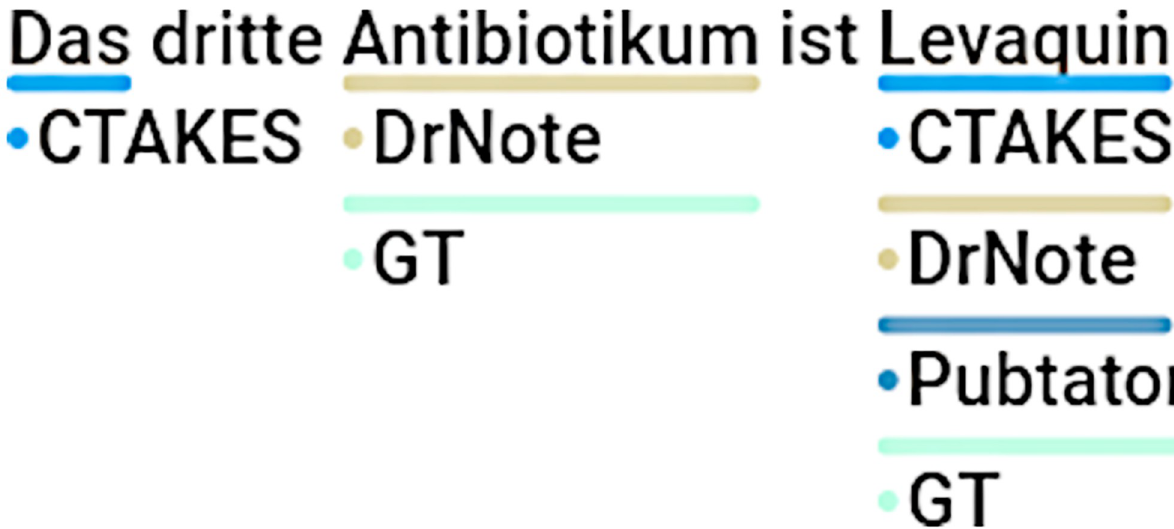
Fig 5. Comparative Sample 3. Artifacts from lack of German linguistics ( Das , cTAKES).